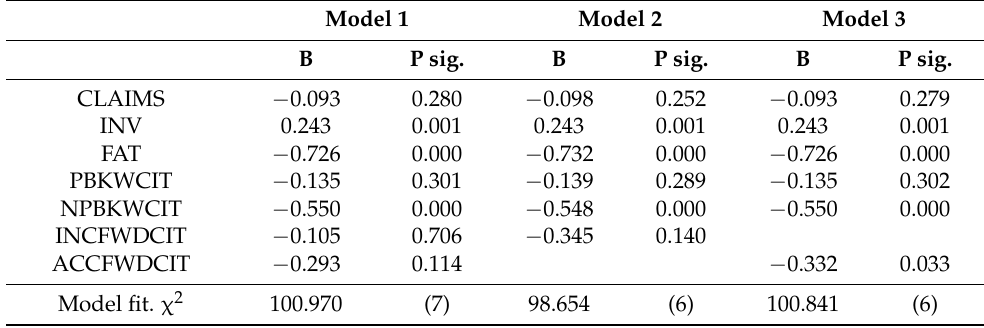
Table 2. Cox regression